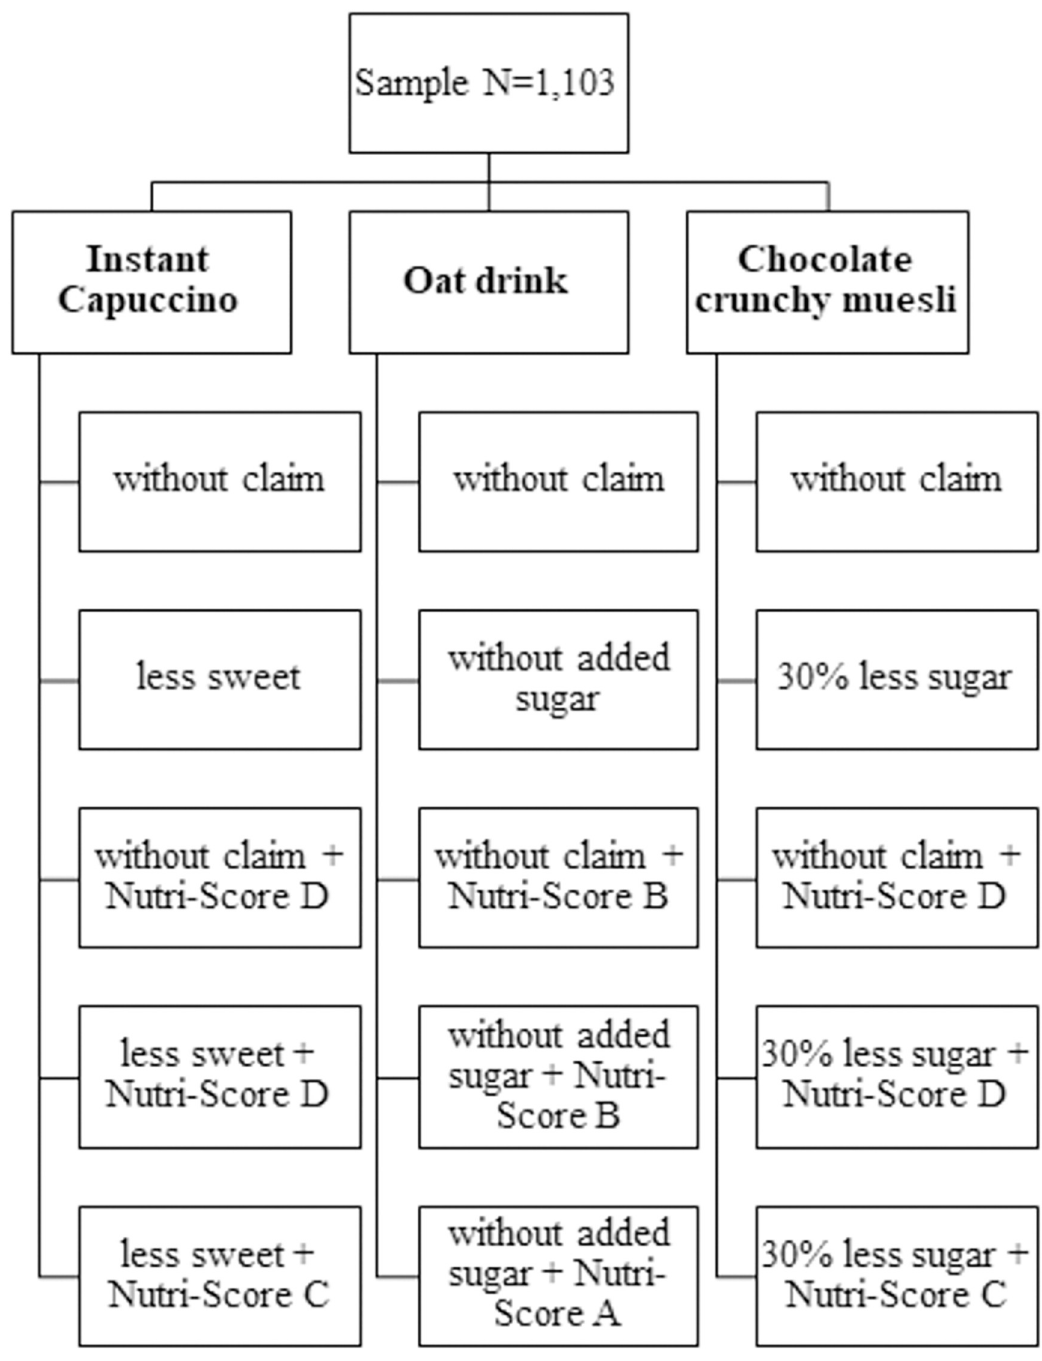
Fig 1. Overview of the three products and included claims. Note: A split sample design was used. ’Without claim’ means that this subsample had no claim on the product.